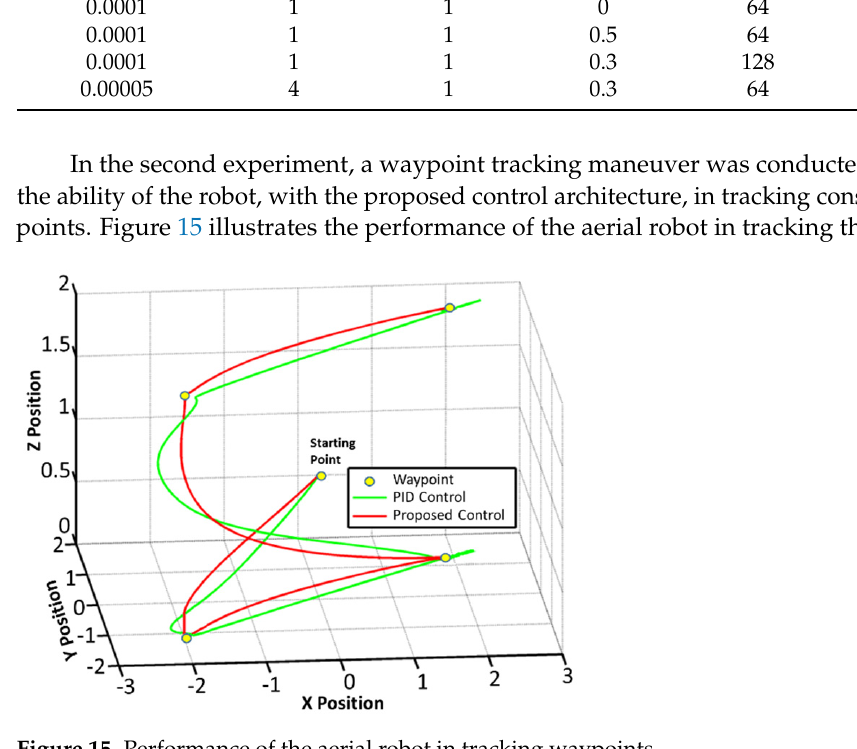
Table 5. Variation of RL hyperparameters and their effect on the steady-state error.